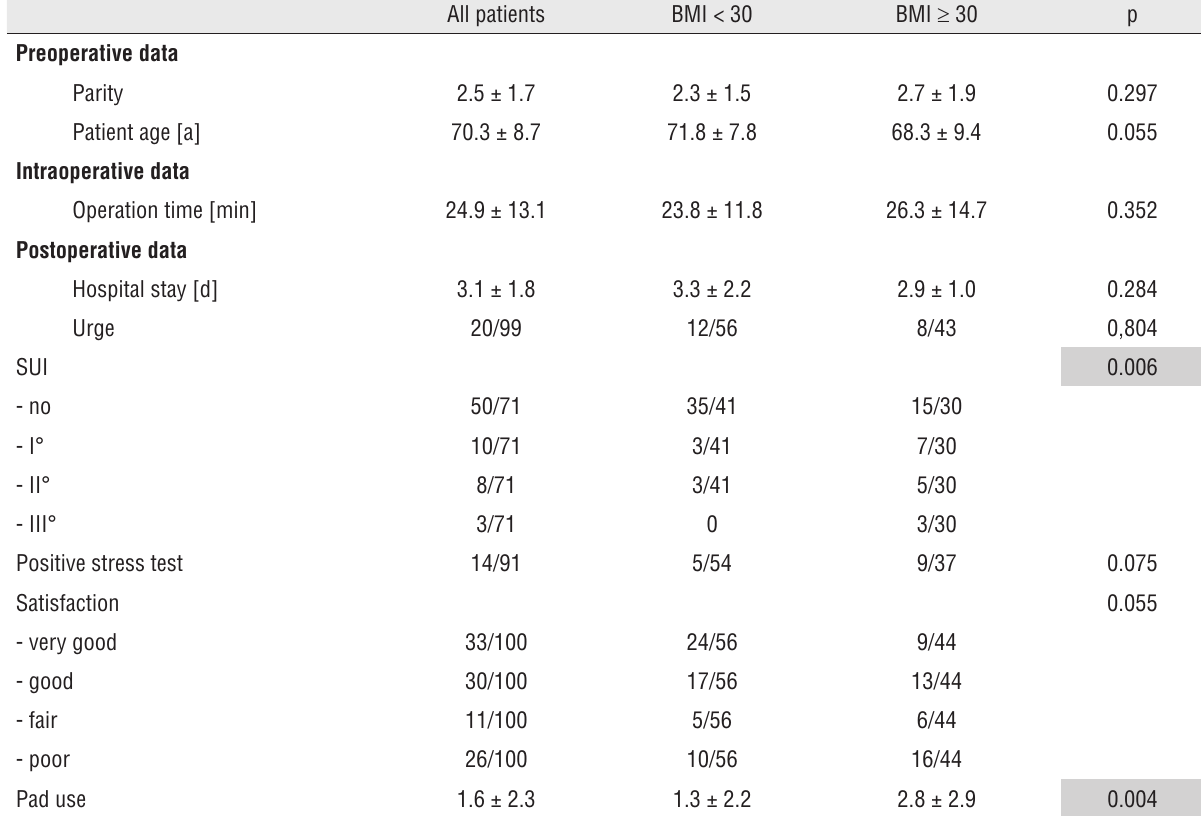
Table 1 - Pre-, intra-and postoperative data. Postoperative SUI and postoperative pad use are significant lower in patients with BMI <30. Data presented as mean value±standard deviation or relative